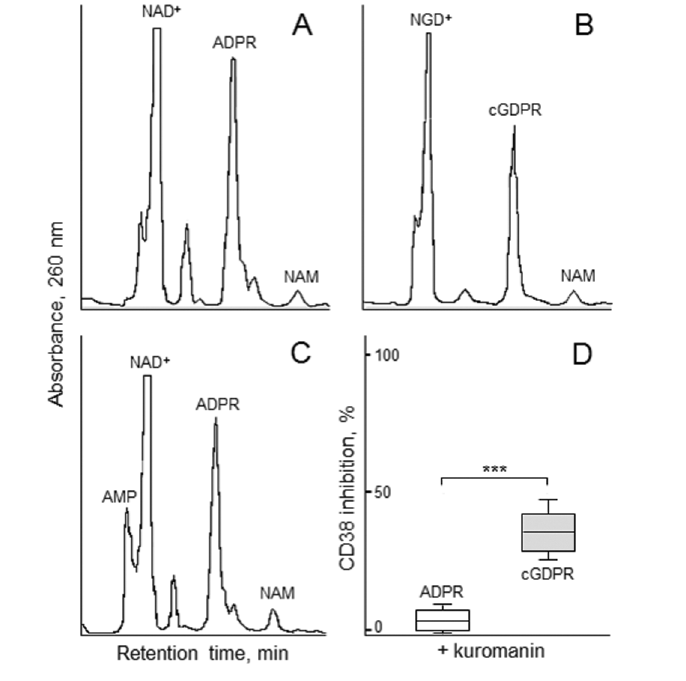
Figure 4. CD38 enzymatic functions in primary myeloma cells and the myeloma cell line. Nucleotide consumption was evaluated using MM cells (2 × 10 6 cell/mL) incubated in HBSS containing NAD + or NGD + (100 µ mol/L), in the presence of a STOP Solution (see Materials and Methods). After centrifugation, supernatants were processed for